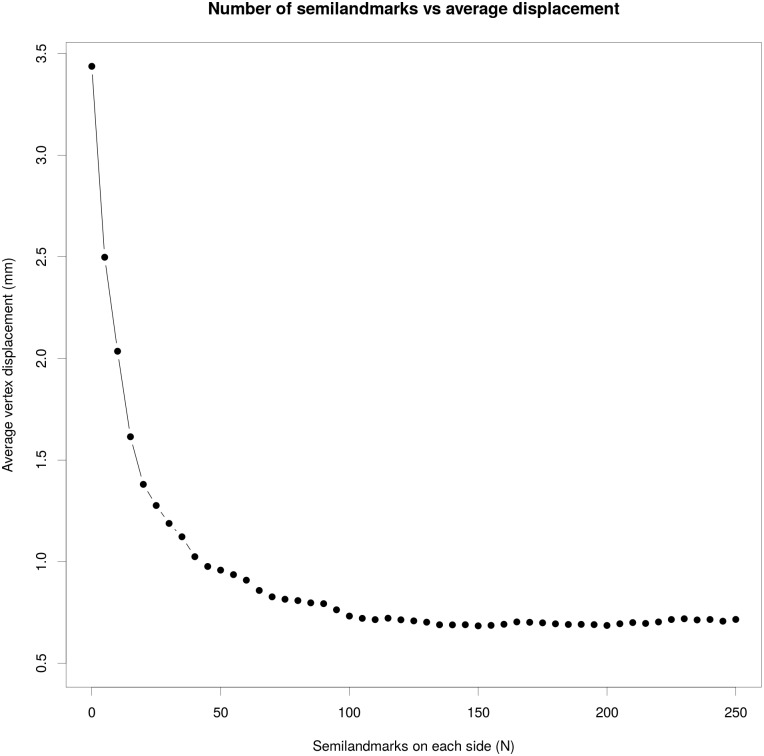
Relation between number of semi-landmarks and recovery of anatomical information (Gorilla case study).In the plot are reported the number of semilandmark per side (x axis) used at each iteration and the respective amount of vertex displacement (y axis) after the retrodeformation procedure.